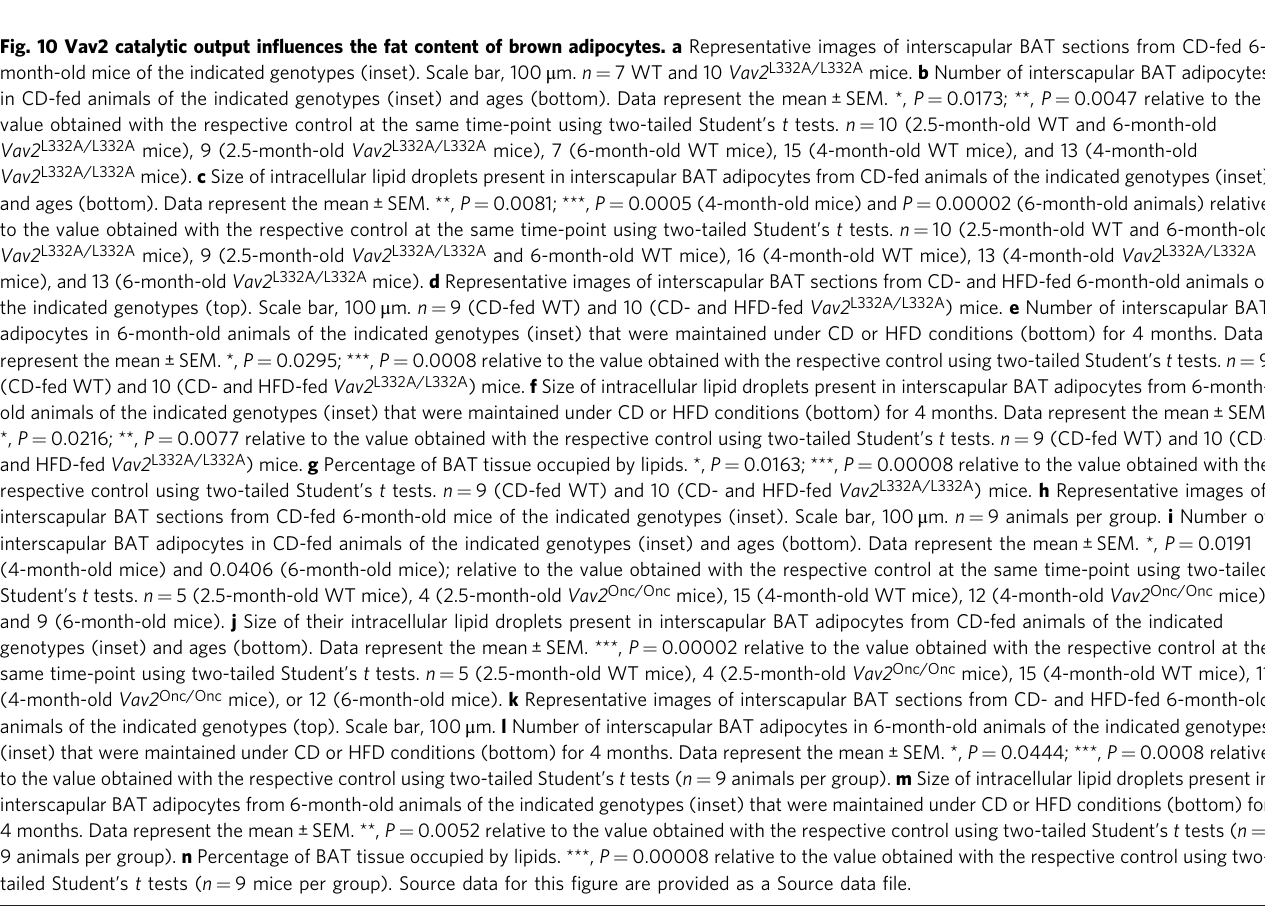
Fig. 10 Vav2 catalytic output in fl uences the fat content of brown adipocytes. a Representative images of interscapular BAT sections from CD-fed 6- month-old mice of the indicated genotypes (inset). Scale bar, 100 μ m. n = 7 WT and 10 Vav2 L332A/L332A mice. b Number of interscapular BAT adipocytes in CD-fed animals of the indicated genotypes (inset) and ages (bottom). Data represent the mean ± SEM. *, P = 0.0173; **, P = 0.0047 relative to the value obtained with the respective control at the same time-point using two-tailed Student ’ s t tests. n = 10 (2.5-month-old WT and 6-month-old Vav2 L332A/L332A mice), 9 (2.5-month-old Vav2 L332A/L332A mice), 7 (6-month-old WT mice), 15 (4-month-old WT mice), and 13 (4-month-old Vav2 L332A/L332A mice). c Size of intracellular lipid droplets present in interscapular BAT adipocytes from CD-fed animals of the indicated genotypes (inset) and ages (bottom). Data represent the mean ± SEM. **, P = 0.0081; ***, P = 0.0005 (4-month-old mice) and P = 0.00002 (6-month-old animals) relative to the value obtained with the respective control at the same time-point using two-tailed Student ’ s t tests. n = 10 (2.5-month-old WT and 6-month-old Vav2 L332A/L332A mice), 9 (2.5-month-old Vav2 L332A/L332A and 6-month-old WT mice), 16 (4-month-old WT mice), 13 (4-month-old Vav2 L332A/L332A mice), and 13 (6-month-old Vav2 L332A/L332A mice). d Representative images of interscapular BAT sections from CD- and HFD-fed 6-month-old animals of the indicated genotypes (top). Scale bar, 100 μ m. n = 9 (CD-fed WT) and 10 (CD- and HFD-fed Vav2 L332A/L332A ) mice. e Number of interscapular BAT adipocytes in 6-month-old animals of the indicated genotypes (inset) that were maintained under CD or HFD conditions (bottom) for 4 months. Data represent the mean ± SEM. *, P = 0.0295; ***, P = 0.0008 relative to the value obtained with the respective control using two-tailed Student ’ s t tests. n = 9 (CD-fed WT) and 10 (CD- and HFD-fed Vav2 L332A/L332A ) mice. f Size of intracellular lipid droplets present in interscapular BAT adipocytes from 6-month- old animals of the indicated genotypes (inset) that were maintained under CD or HFD conditions (bottom) for 4 months. Data represent the mean ± SEM. *, P = 0.0216; **, P = 0.0077 relative to the value obtained with the respective control using two-tailed Student ’ s t tests. n = 9 (CD-fed WT) and 10 (CD- and HFD-fed Vav2 L332A/L332A ) mice. g Percentage of BAT tissue occupied by lipids. *, P = 0.0163; ***, P = 0.00008 relative to the value obtained with the respective control using two-tailed Student ’ s t tests. n = 9 (CD-fed WT) and 10 (CD- and HFD-fed Vav2 L332A/L332A ) mice. h Representative images of interscapular BAT sections from CD-fed 6-month-old mice of the indicated genotypes (inset). Scale bar, 100 μ m. n = 9 animals per group. i Number of interscapular BAT adipocytes in CD-fed animals of the indicated genotypes (inset) and ages (bottom). Data represent the mean ± SEM. *, P = 0.0191 (4-month-old mice) and 0.0406 (6-month-old mice); relative to the value obtained with the respective control at the same time-point using two-tailed Student ’ s t tests. n = 5 (2.5-month-old WT mice), 4 (2.5-month-old Vav2 Onc/Onc mice), 15 (4-month-old WT mice), 12 (4-month-old Vav2 Onc/Onc mice), and 9 (6-month-old mice). j Size of their intracellular lipid droplets present in interscapular BAT adipocytes from CD-fed animals of the indicated genotypes (inset) and ages (bottom). Data represent the mean ± SEM. ***, P = 0.00002 relative to the value obtained with the respective control at the same time-point using two-tailed Student ’ s t tests. n = 5 (2.5-month-old WT mice), 4 (2.5-month-old Vav2 Onc/Onc mice), 15 (4-month-old WT mice), 11 (4-month-old Vav2 Onc/Onc mice), or 12 (6-month-old mice). k Representative images of interscapular BAT sections from CD- and HFD-fed 6-month-old animals of the indicated genotypes (top). Scale bar, 100 μ m. l Number of interscapular BAT adipocytes in 6-month-old animals of the indicated genotypes (inset) that were maintained under CD or HFD conditions (bottom) for 4 months. Data represent the mean ± SEM. *, P = 0.0444; ***, P = 0.0008 relative to the value obtained with the respective control using two-tailed Student ’ s t tests ( n = 9 animals per group). m Size of intracellular lipid droplets present in interscapular BAT adipocytes from 6-month-old animals of the indicated genotypes (inset) that were maintained under CD or HFD conditions (bottom) for 4 months. Data represent the mean ± SEM. **, P = 0.0052 relative to the value obtained with the respective control using two-tailed Student ’ s t tests ( n = 9 animals per group). n Percentage of BAT tissue occupied by lipids. ***, P = 0.00008 relative to the value obtained with the respective control using two- tailed Student ’ s t tests ( n = 9 mice per group). Source data for this fi gure are provided as a Source data fi